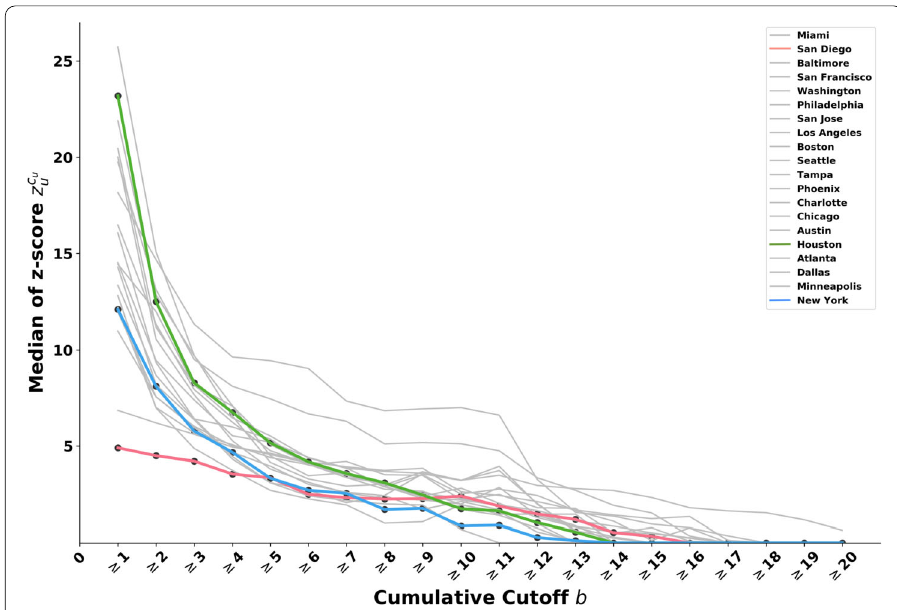
Figure 5 Sensitivity of class-level bias z-score z cu u . Lower bound cutoff is set as b ≥ 1 to which we only